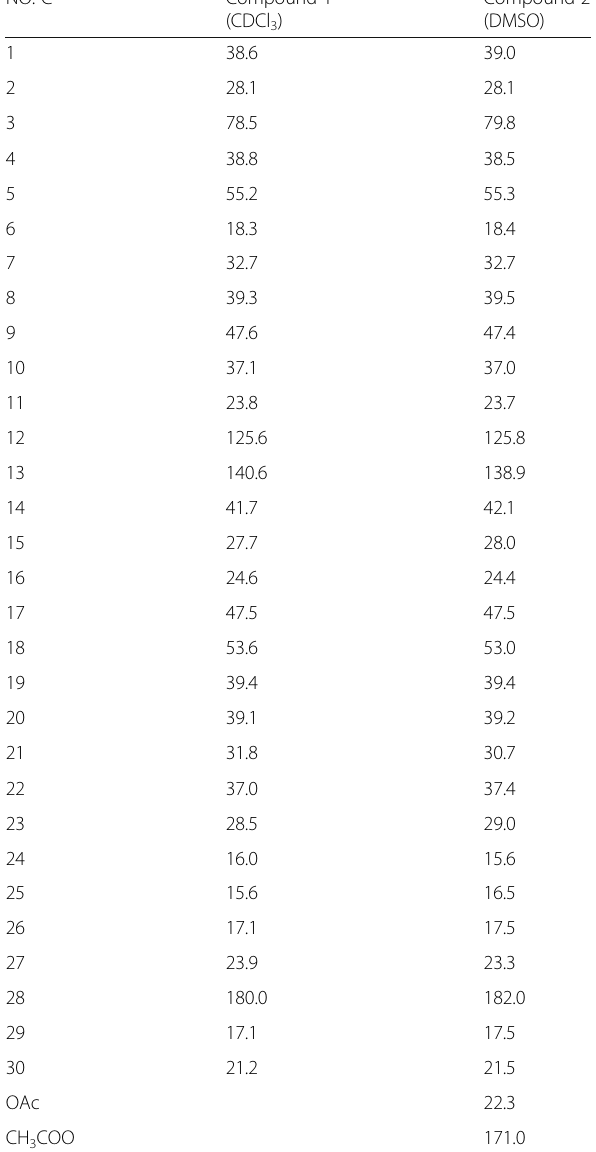
Table 4 13 C NMR (100 MHz) data of compounds 1 and 2 NO.